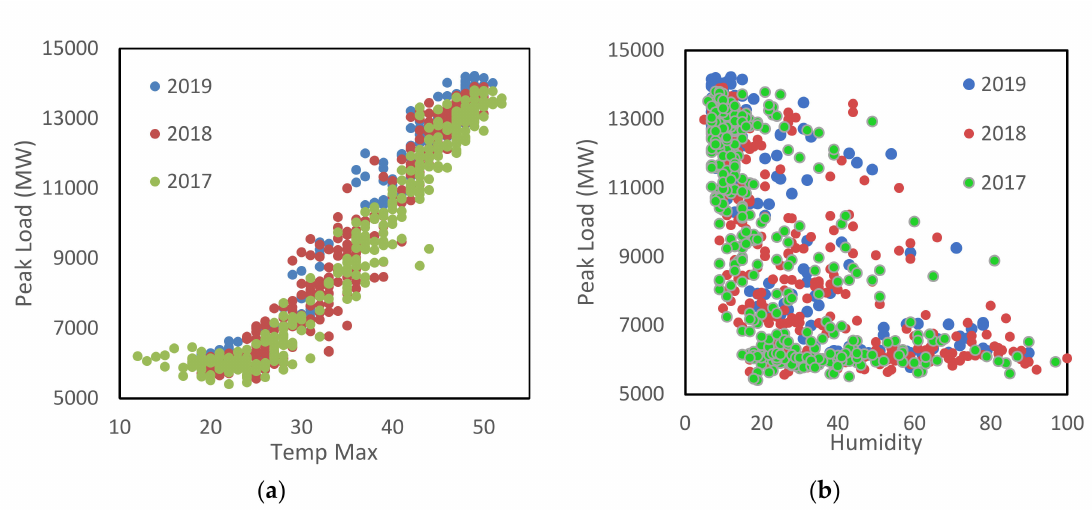
Figure 2. Dataset of the peak electrical load vs ( a ) daily maximum temperature, and ( b ) relative humidity